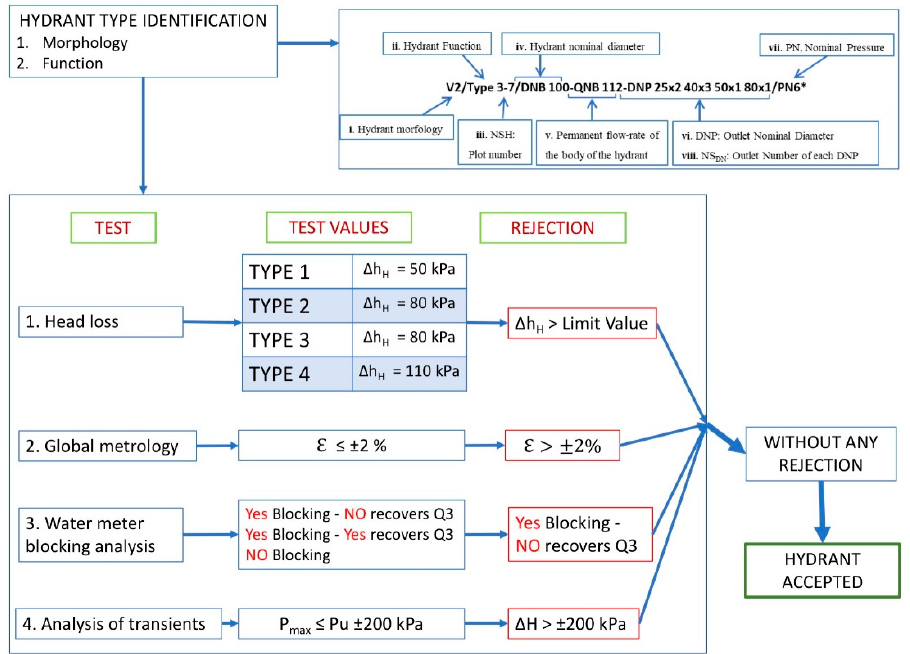
Figure 5. Main laboratory tests and rejection criteria to characterize multioutlet hydrants.